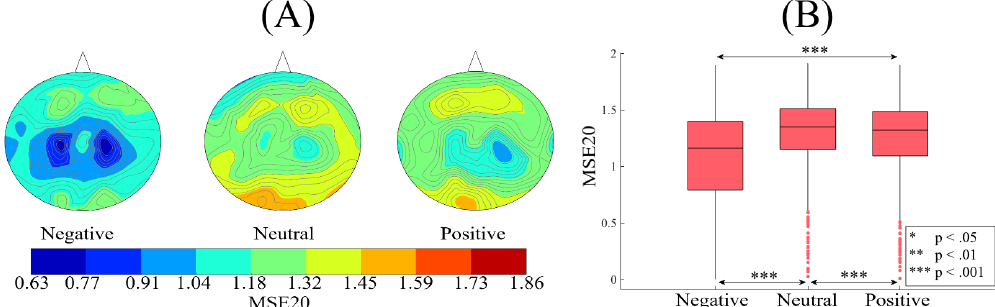
Figure 7. ( A ) Grand averages of the spatial maps of participants’ MSE20s (i.e., 62 MSE20s associated with 62 EEG channels of a participant, per affect) in negative, neutral, and positive mental states. Distribution of MSE20s in these spatial maps corresponds to the EEG channels’ arrangement in Figure 1B (i.e., one MSE20 value, per EEG channel). These subplots identify a pattern in which MSE20s associated with the neutral state is higher than the negative as well as the positive state. Similar to participants’ MSE1s, the negative state’s MSE20s are below those of the neutral and the positive states. ( B ) Descriptive statistics of the posthoc Wilcoxon rank-sum tests applied on participants’ whole-brain MSE20s (i.e., 62 MSE20s associated with 62 EEG channels of a participant, per